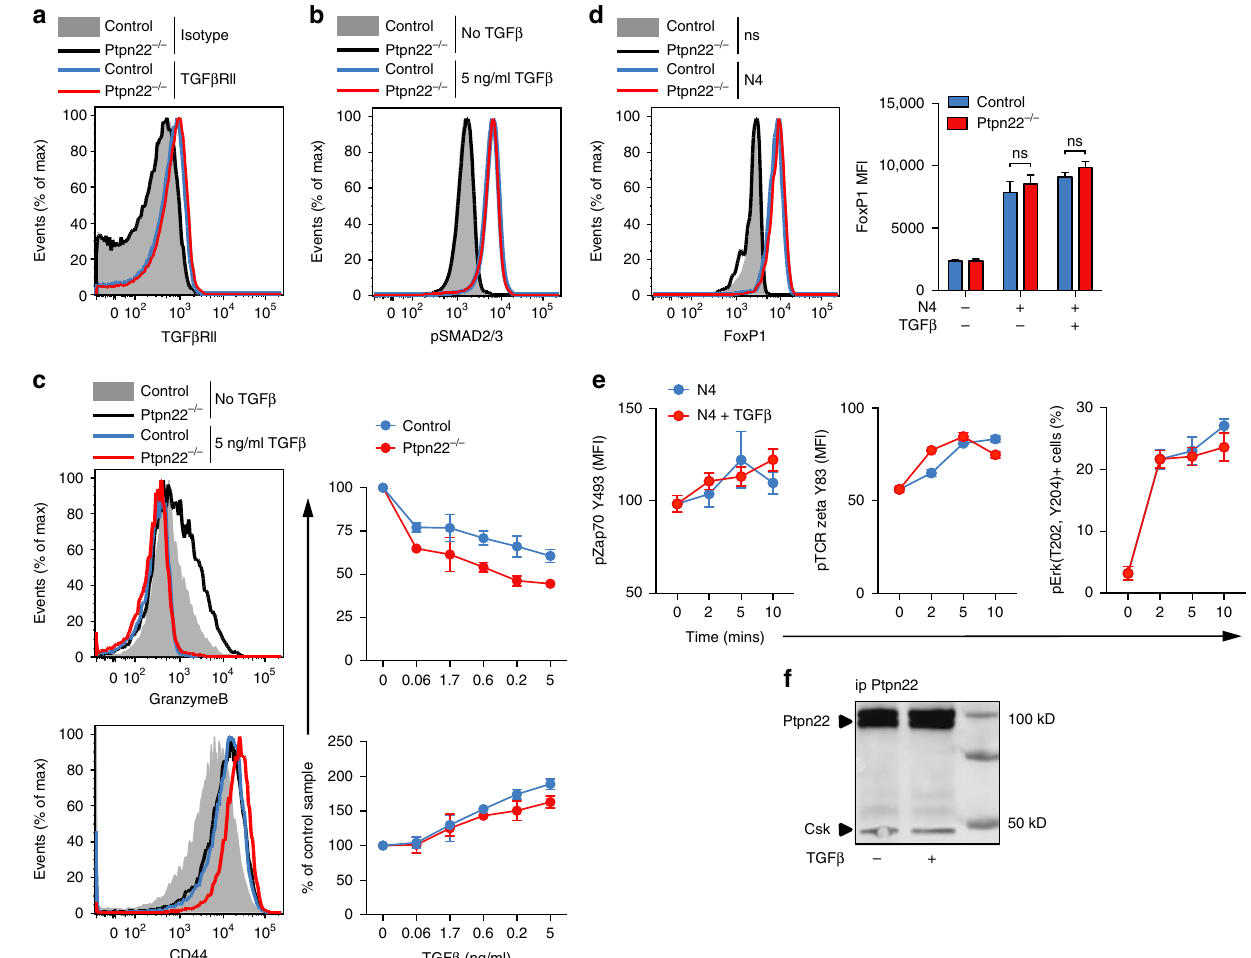
Fig. 4 TGF β signaling is not affected by the absence of PTPN22. Histogram overlays show equivalent expression in control and Ptpn22 − / − OT-1 cells of a cell surface TGF β RII and b intracellular SMAD2/3 phosphorylation (pSMAD) after stimulation with 5 ng/ml TGF β for 30 min. c The TGF β -regulated genes granzyme B and CD44 were down- and upregulated, respectively, in both control and Ptpn22 − / − OT-1 cells by TGF β in a dose-dependent manner after activation with N4 10 − 8 M TGF β for 24 h. d FoxP1 induction was comparable in the presence of N4 10 − 8 M in control and Ptpn22 − / − OT-1 cells ± 5 ng/ml TGF β for 24 h. e Intracellular phosphorylation of Zap70, TCR zeta and ERK in OT-1 cells after TCR stimulation with N4 10 − 6 M ± 5ng/ml TGF β for 0 – 10 min. f Co-immunoprecipitation of Ptpn22 and Csk in OT-1 cells pretreated ± TGF β for 2.5 h. Data are from one experiment representative of at least three experiments (mean and s.d. of three replicates). Non signi fi cance (ns) as determined using two-way ANOVA with Tukey ’ s post test for multiple comparisons common gamma chain cytokines on TGF β suppression has been reported 7,30 . We found that, compared with control cells, − / − Ptpn22 OT-1 T cells secreted signi fi cantly greater quantities of IL-2 in response to both strong N4 and weak T4 agonist peptides (Fig. 5c, *** p < 0.001 and **** p < 0.0001 using two-way ANOVA with Tukey ’ s post test). Importantly, TGF β treatment almost IL-2 protects against TGF β -mediated suppression . Our data − / − OT-1 T cell IL-2 completely blocked control but not Ptpn22 suggested that indirect mechanisms were likely to underlie the production (Fig. 5c). ability of Ptpn22 − / − T cells to resist TGF β inhibition. Serendipi- − / − Two distinct approaches con fi rmed the importance of elevated tously, we noted that when control and Ptpn22 OT-1 T cells TCR-induced IL-2 production for the ability of Ptpn22 − / − T cells were activated with T4 peptide as a 1:1 mix in the same culture to resist TGF β -mediated inhibition. First, canonical IL-2- wells, the inhibitory effect of TGF β on control T cell proliferation dependent signaling pathways were blocked using the inhibitor was abrogated (Fig. 5a). These data suggested that Ptpn22 − / − tofacitinib, which inhibits Jak3 in addition to other members of T cells secreted or expressed a factor that “ rescued ” control cells from the effects of TGF β in a co-culture system. Culture of control and Ptpn22 − / − T cells in transwells also abrogated indicating that IL-2 cytokine receptor signaling was important for the inhibitory effect of TGF β on control T cell proliferation, − / − cells to TGF β (Fig. 5d). Second, the the resistance of Ptpn22 indicating that a soluble factor was responsible for the addition of recombinant IL-2 to T cell cultures prevented the protective effect (Fig. 5a, b). TGF β was shown to limit T cell IL-2 inhibitory effects of TGF β on OT-1 T cell proliferation when production 20,28,29 and a protective effect of IL-15 and other NATURE COMMUNICATIONS | 8: 1343 | DOI: 10.1038/s41467-017-01427-1 |